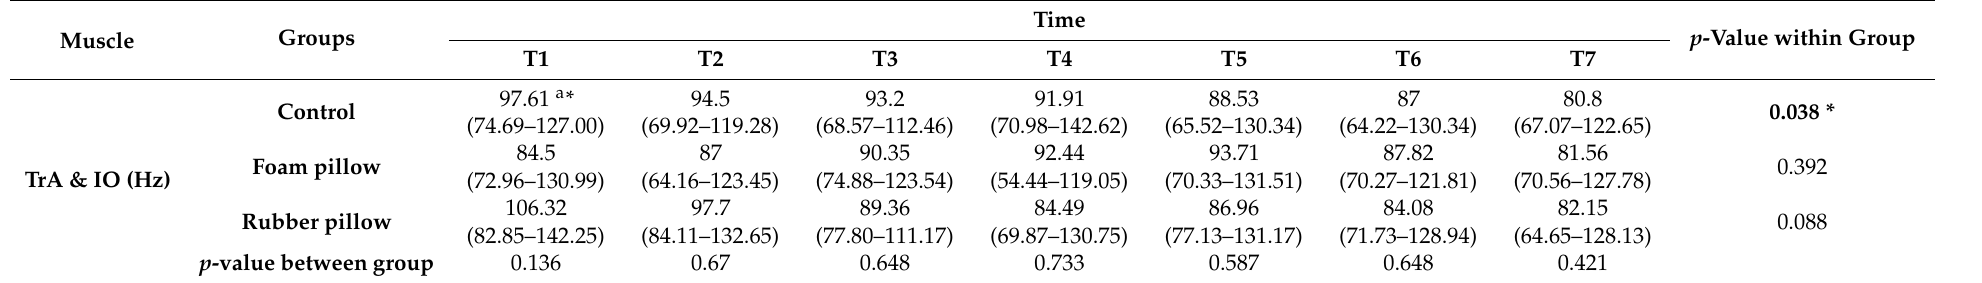
Table 4. Trunk muscle (TrA and IO) fatigue while sitting for 60